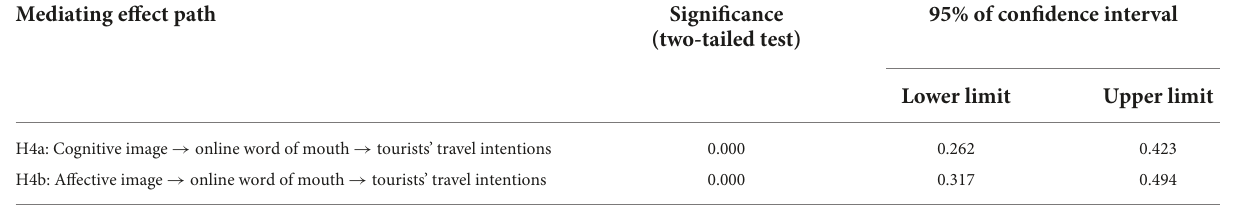
TABLE 6 Bootstrap test results of the significance of the mediating